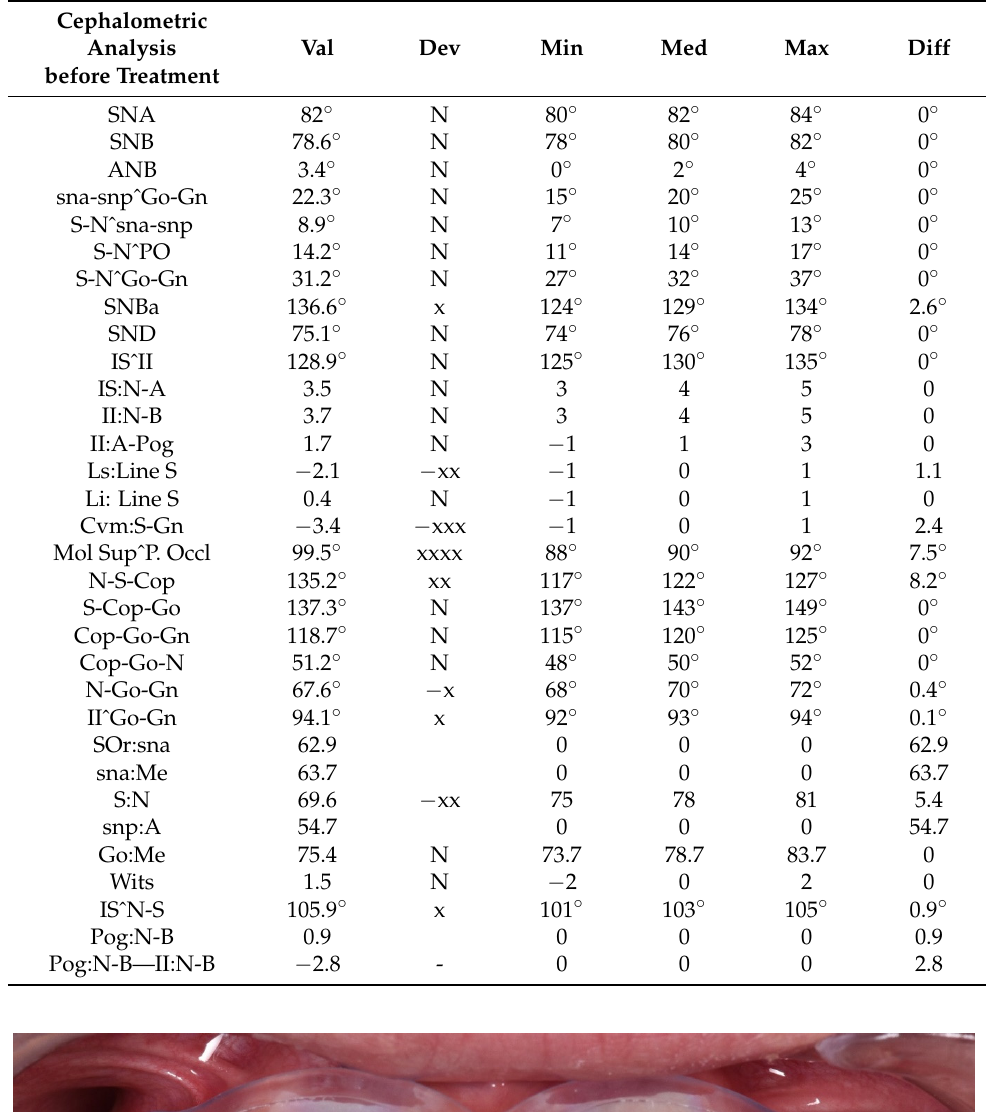
Table 1. Cephalometric analysis before treatment.